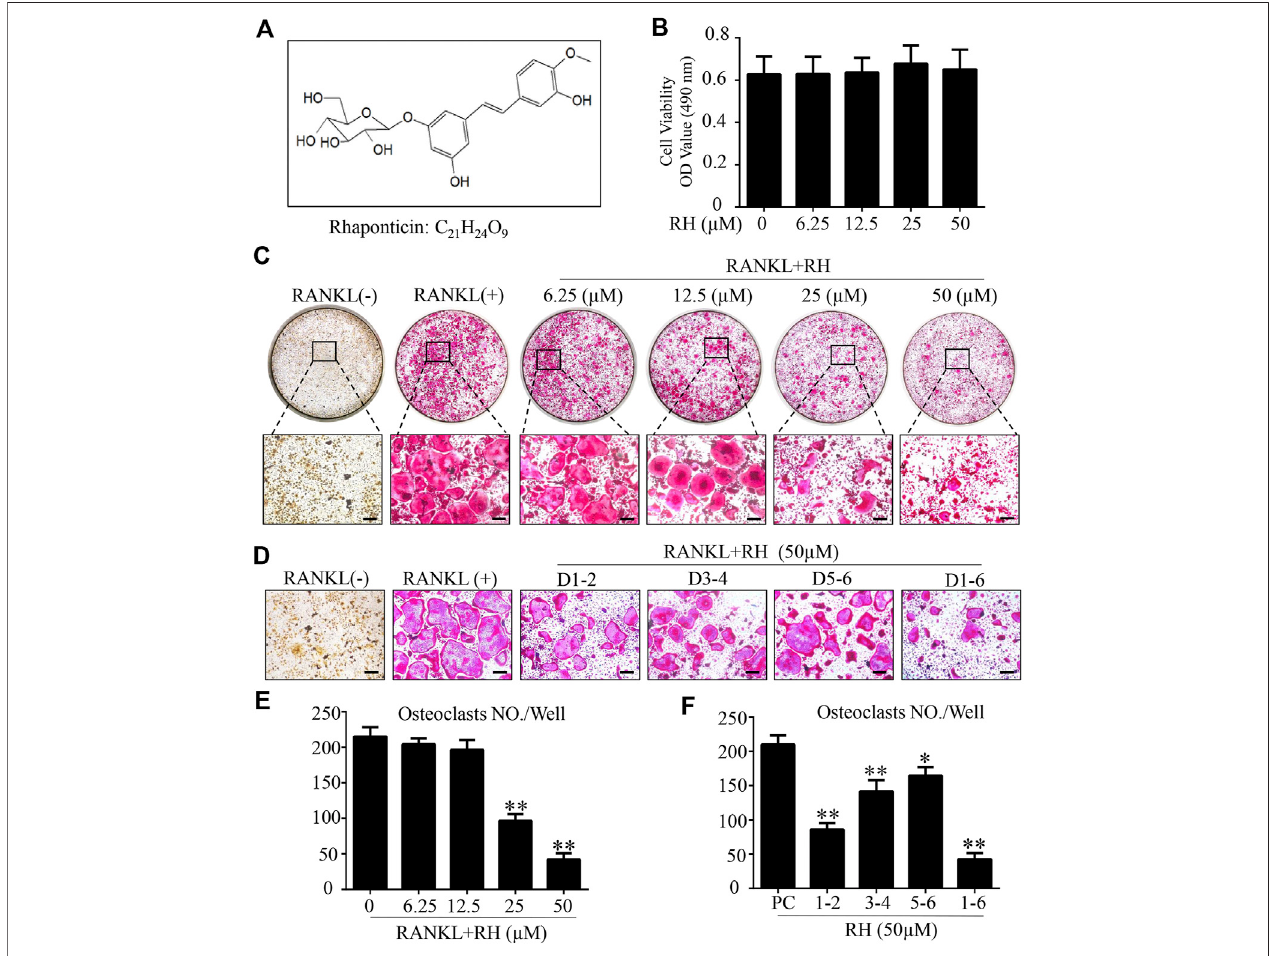
FIGURE 1 | Rhaponticin (RH) suppressed RANKL-induced osteoclastogenesis in vitro . (A) Chemical structure and formula of RH. (B) MTS assay of the BMMs culturedwithvariousconcentrationsofRH. (C,D) RepresentativeimagesofopticalmicroscopeandTRAcPstainingofBMMstreatedwithRHindifferentconcentrations for 6 days (C) and in 50 μ M, at different time phase of 1 – 2 days (D1-2), 3 – 4 days (D3-4), 5 – 6 days (D5-6), 1 – 6 days (D1-6), during differentiation (D) were shown. (E, F) Quanti fi cation of TRAcP positive multinucleated osteoclasts (nuclei > 3) with the treatment of RH ( n (cid:2) 3). * p < 0.05, ** p < 0.01 relative to RANKL-induced control group. Scale bar (cid:2) 200 μ